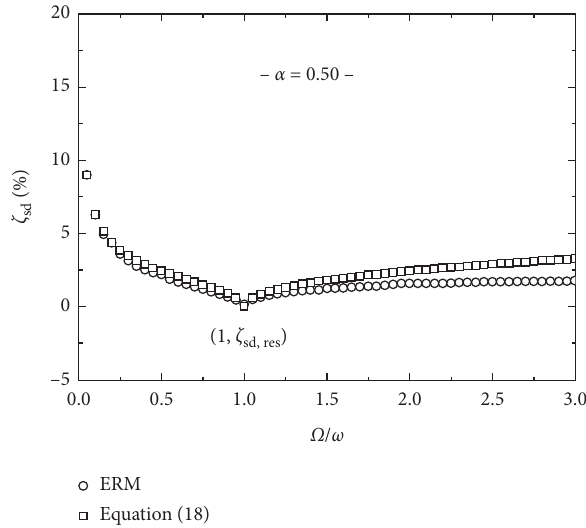
Figure 3: Comparison of the ADRs calculated using the two methods with different frequency ratios ( α � 0.50).